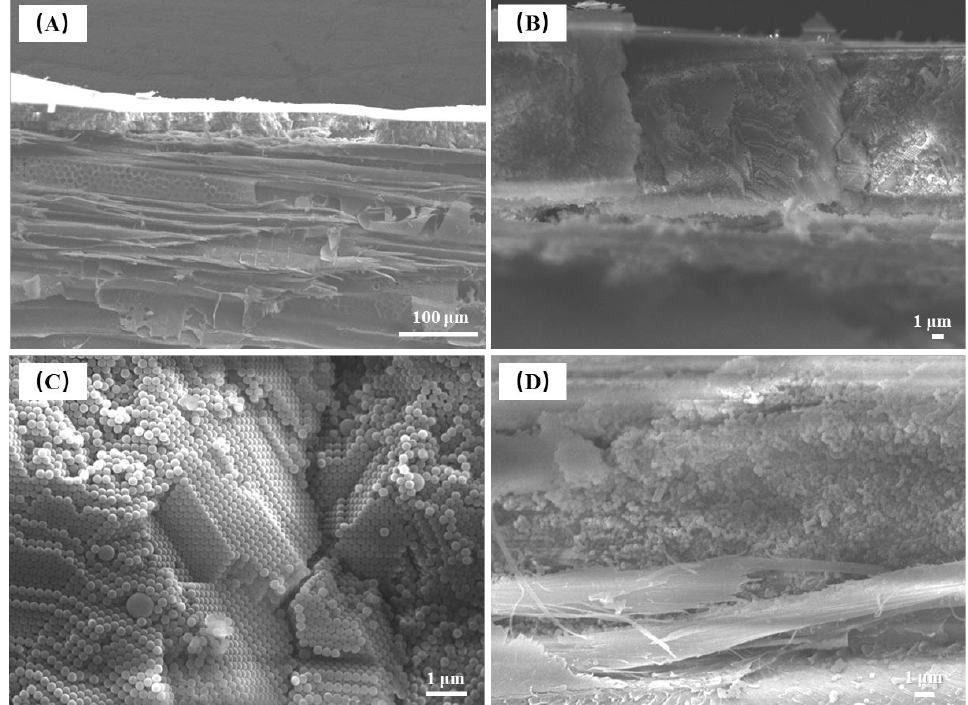
Figure 21. Sectional view FE-SEM images of photonic crystals formed by the self-assembly of P(St-AA) colloidal microspheres on the wood surface: ( A ) micromorphology of photonic crystals and wood; ( B ) low-magnification view of the photonic crystal; ( C ) high-magnification view of the well-ordered part; ( D ) high-magnification view of the disordered part.